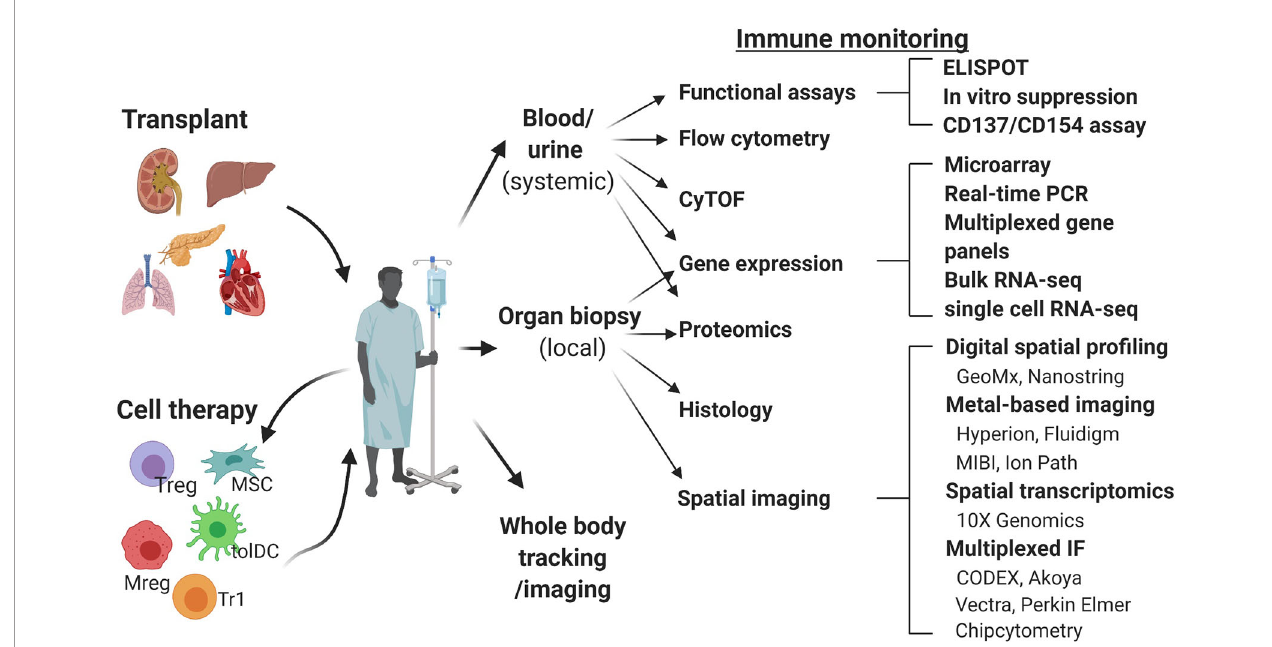
FIGURE 1 | Schematic overview of the immune monitoring methods useful in cell therapy trials in transplantation. CODEX, co-detection by indexing; CyTOF, cytometry of the time of fl ight; IMC, imaging mass cytometry; MIBI, multiplexed ion beam imaging; Mreg, regulatory macrophage; MSC, mesenchymal stem cell; RT- qPCR, real time quantitative polymerase chain reaction; tolDC, tolerogenic dendritic cell; Treg, regulatory T cell; Tr1, type 1 regulatory T